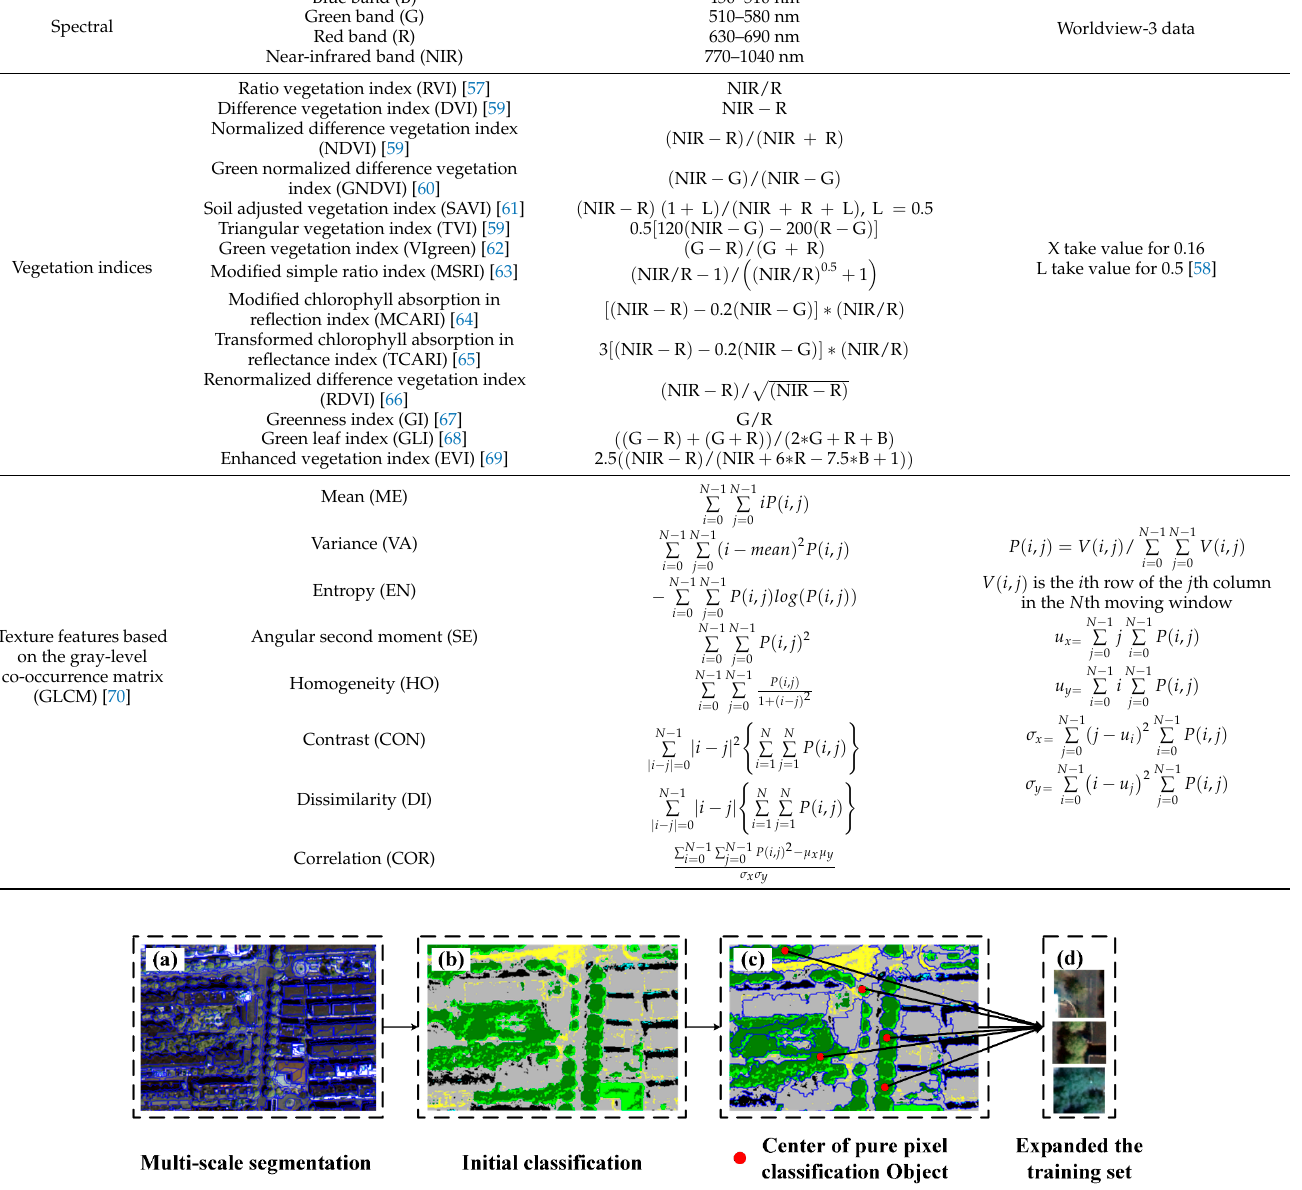
Figure 2. Multi-scale segmentation-based sample selection. Segment the VHRRS image with multi-scale segmentation and select the center pixel of each object with a “pure” classification to enlarge the training set. ( a ) Multi-scale image segmentation; ( b ) initial classification diagram of the RF 0 ; ( c ) selection of the center pixel of an object; ( d ) expanded training